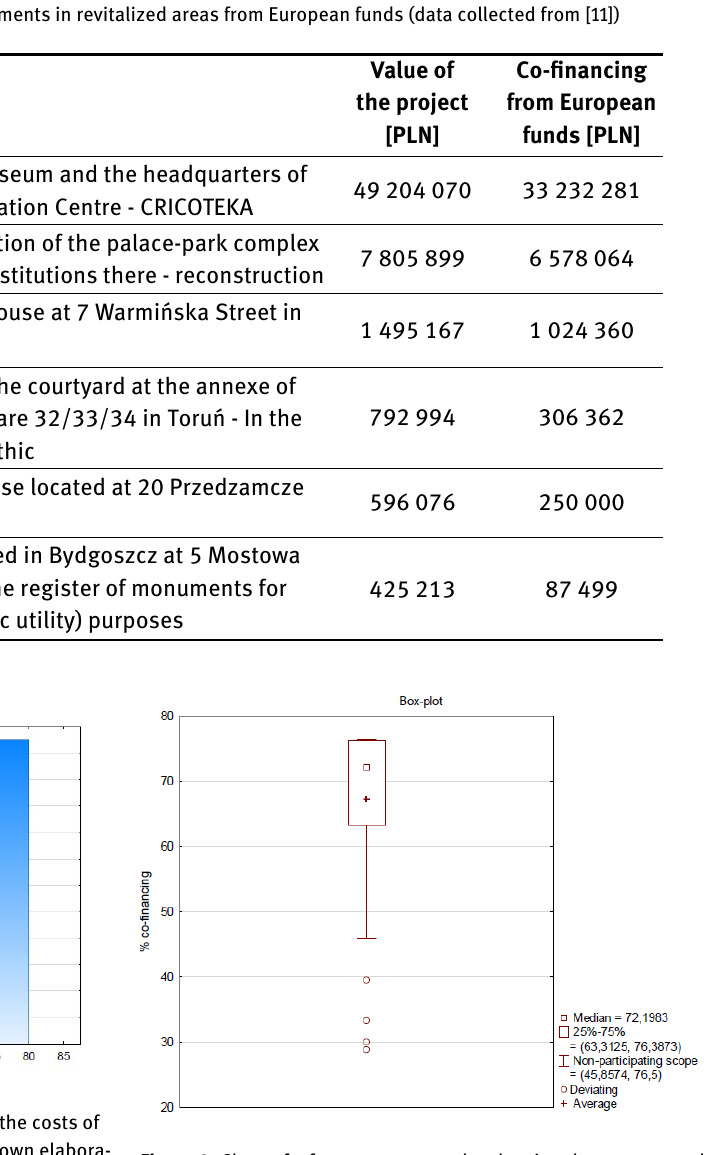
Figure 3: Chart of a frame - a moustache showing the average and median of co-financing of projects covered by RP (own